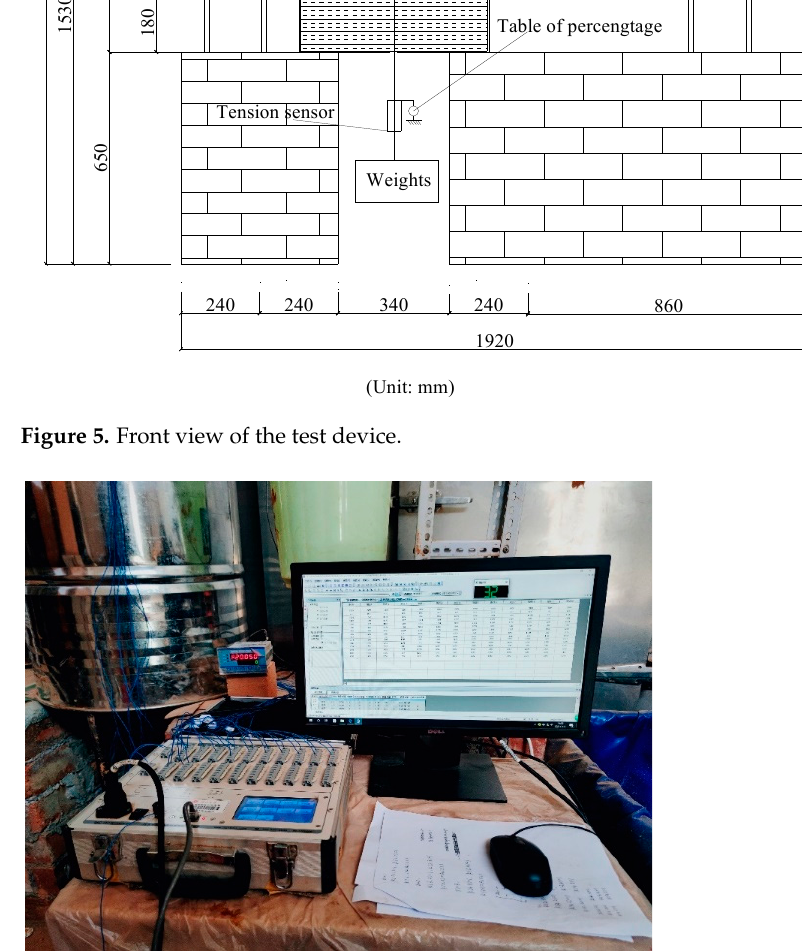
Figure 6. TST3822EN wireless static strain test and analysis system.